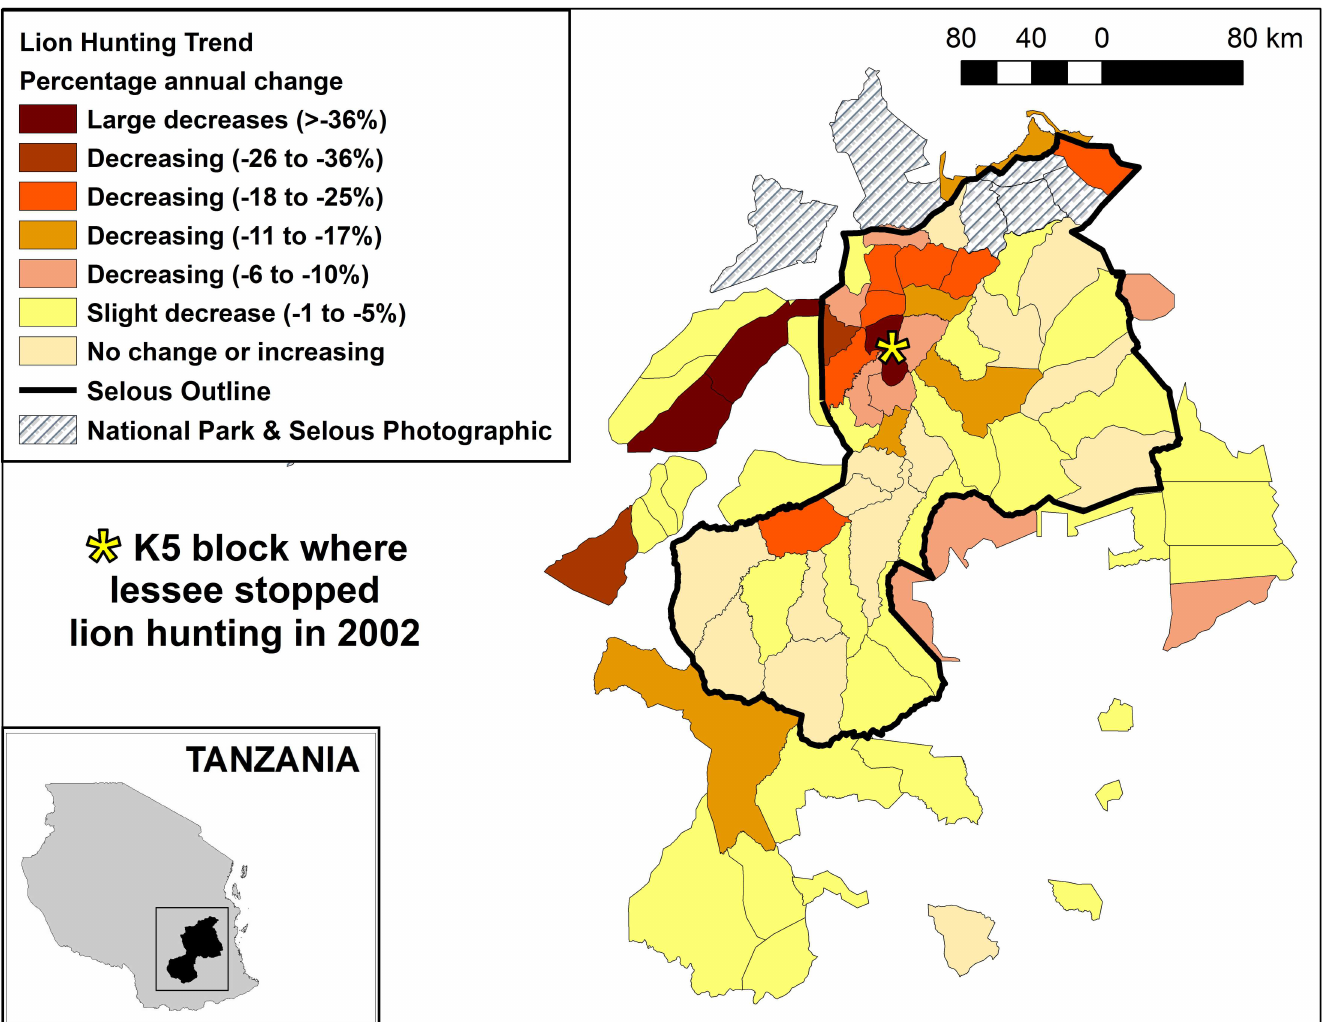
Fig 3. Map showingannual changein annuallion hunting(1996–2008) in SelousGame Reserve and surrounding